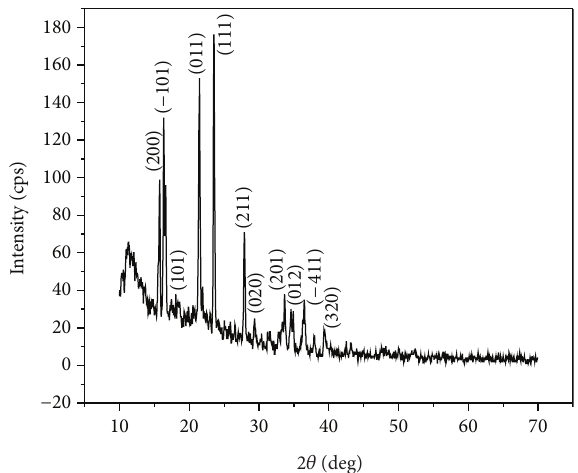
F 1: Indexed X-ray powder diffraction pattern Cu